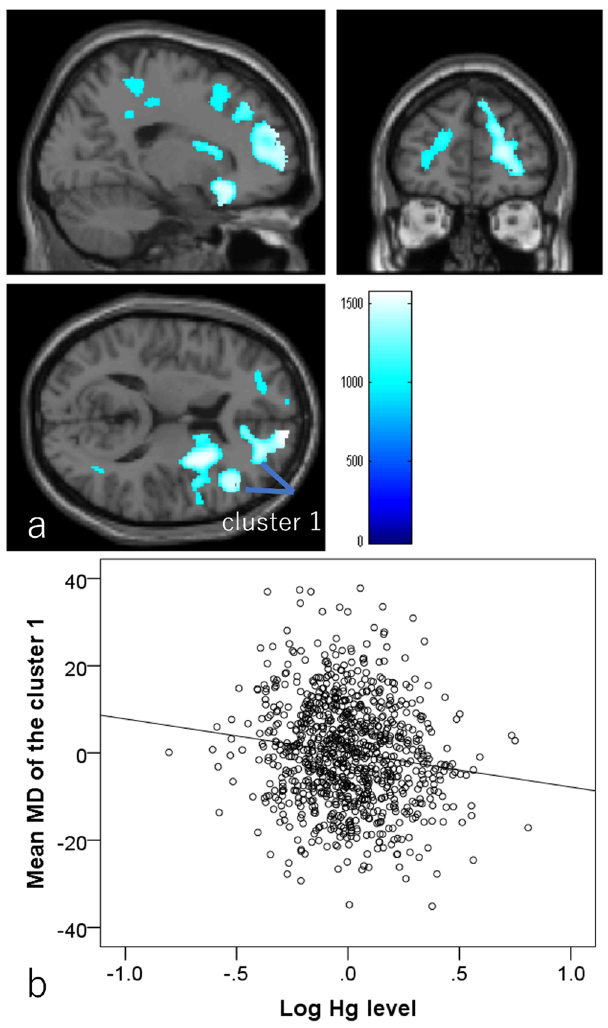
Fig. 5 Associations of hair mercury level with mean diffusivity (MD) ( N = 919). Greater hair mercury level was signi fi cantly associated with lower MD in widespread bilateral gray and white matter areas. Colored bars indicate TFCE scores. TFCE score is unit-free and re fl ects both voxel ’ s height and the sum of the spatially contiguous voxels supporting it; therefore, it re fl ects both the strength and extent of effects. All results are overlaid on a single-subject T1-weighted SPM8 image. a Regions with signi fi cant correlations. The results shown were obtained at a threshold P < 0.05, corrected for multiple comparisons based on 5000 permutations using the TFCE score. b Partial residual plots with trend line depicting the associations between residuals of log (hair mercury) and residuals of mean MD in the signi fi cant cluster spread across the right hemisphere, with other confounding factors for the association between body concentration of lead (a well- known neurotoxin) and individual cognitive differences 2 .